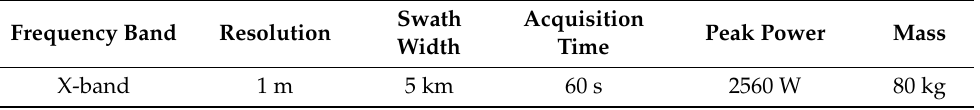
Table 2. S-STEP system performance parameter.